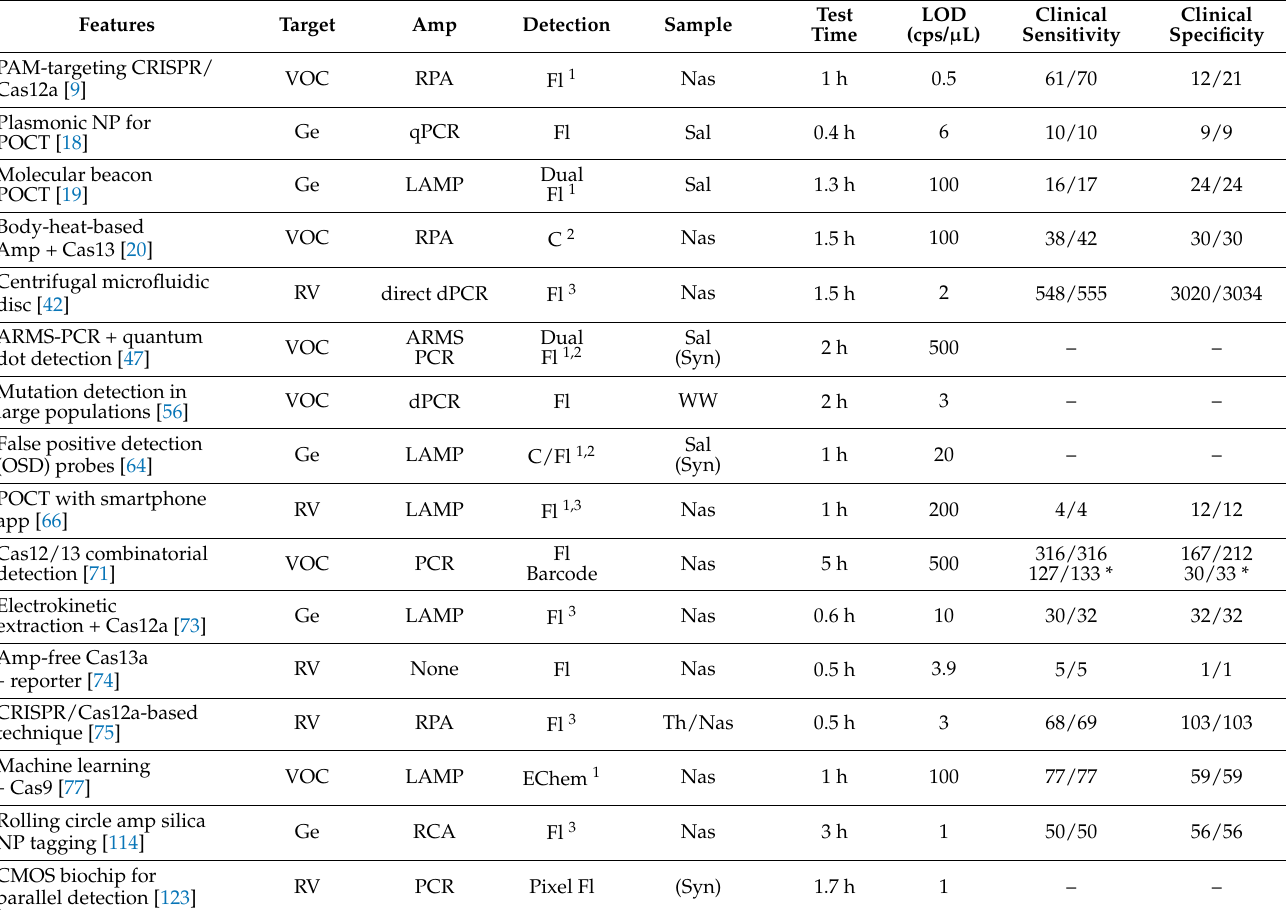
Table 1. Summary table of multiplex nucleic acid diagnostic tests for